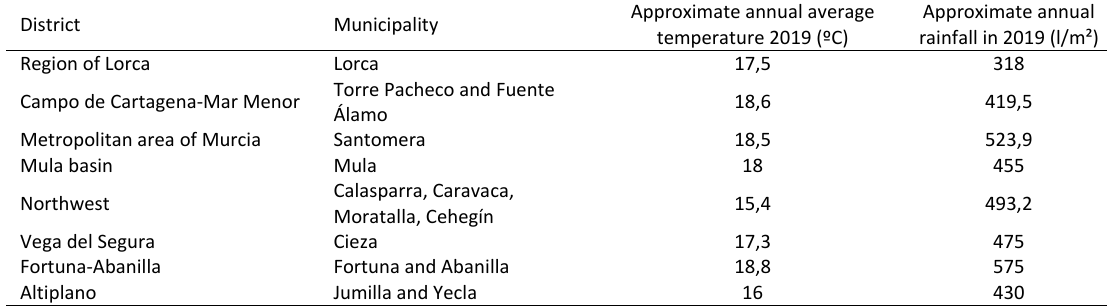
Table 3: Average annual temperature and annual rainfall by region with quarries